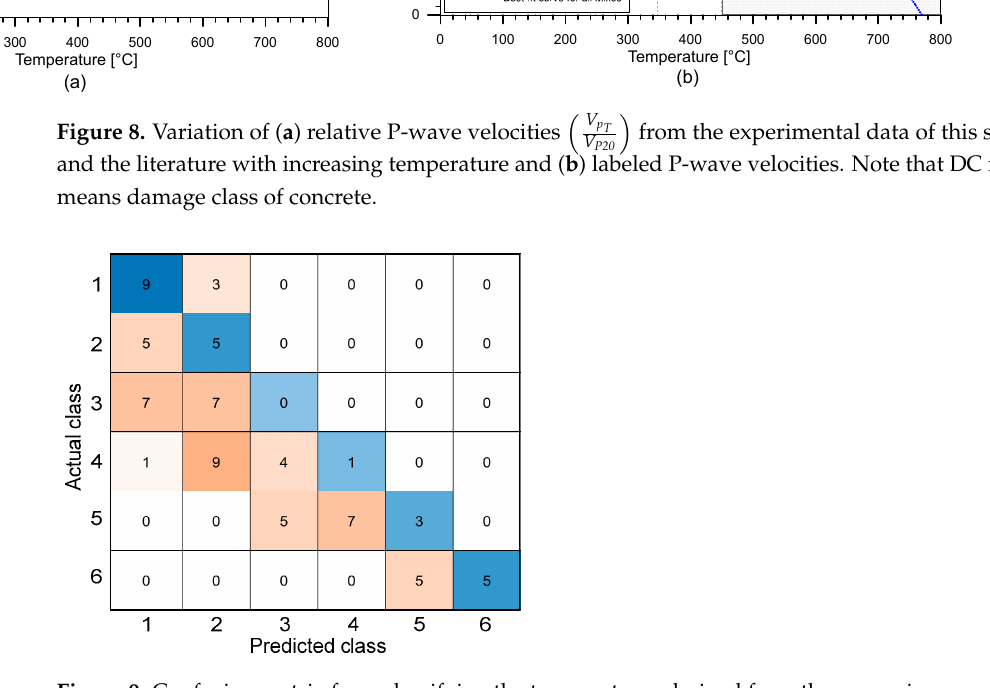
Figure 9. Confusion matrix from classifying the temperatures derived from the regression equations used from P-wave velocities.